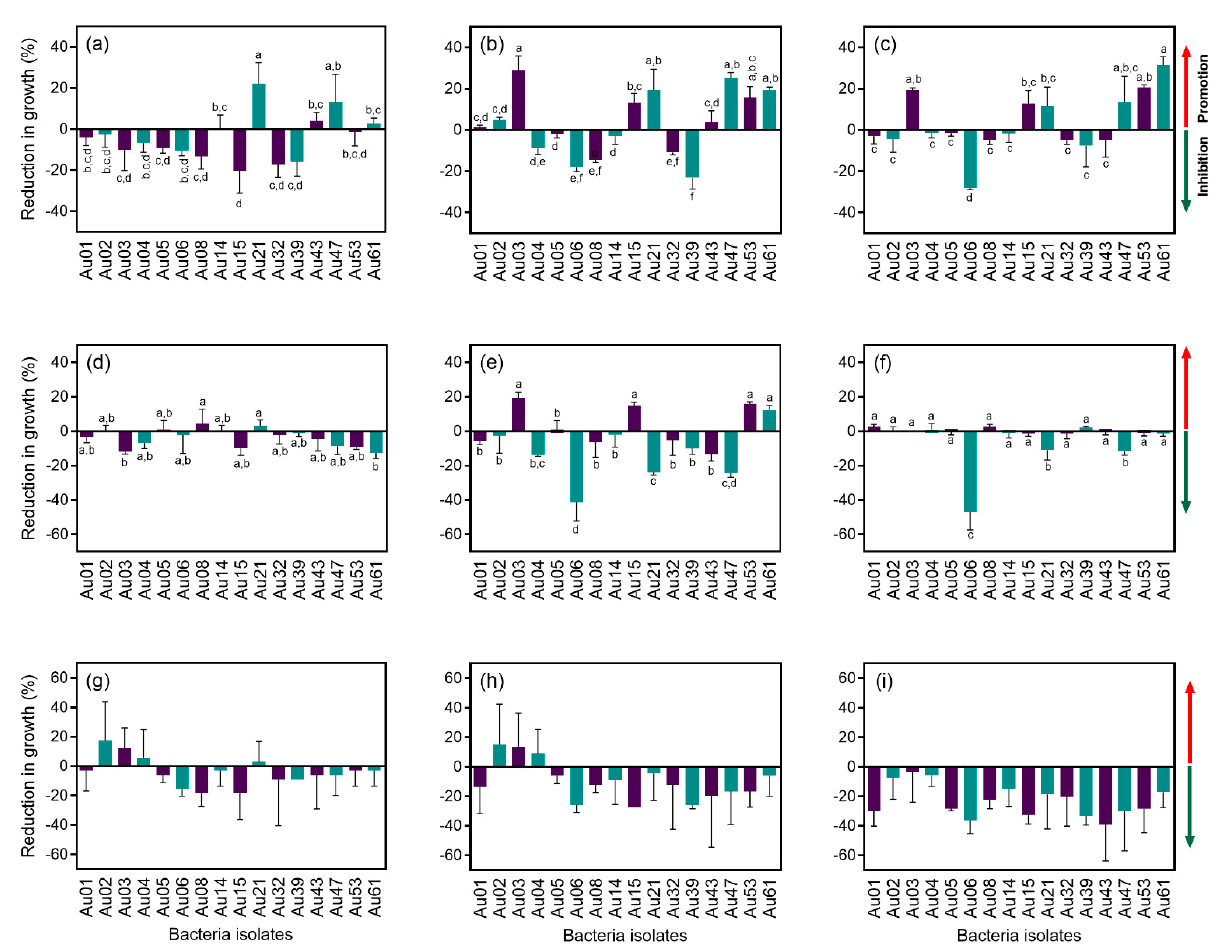
Figure 4. Antagonism assay between some of the endophytic bacteria isolated from Arbutus unedo and the plant pathogens Glomerella cingulata , Mycosphaerella aurantia and Phytophthora cinnamomi . Reduction in growth (%) was calculated after 1, 2 and 3 weeks for G. cingulata and P. cinnamomi , and after 3, 6 and 9 weeks for M. aurantia . ( a ) G. cingulata after 1 week; ( b ) G. cingulata after 2 weeks; ( c ) G. cingulata after 3 weeks; ( d ) M. aurantia after 3 weeks; ( e ) M. aurantia after 6 weeks; ( f ) M. aurantia after 9 weeks; ( g ) P. cinnamomi after 1 week; ( h ) P. cinnamomi after 2 weeks; ( i ) Phytophthora cinnamomi after 3 weeks. Bacteria isolates: Au01— Pseudomonas avellanae ; Au02— Bacillus toyonensis ; Au03— Paenibacillus humicus ; Au04— Bacillus megaterium ; Au05— Bacillus toyonensis ; Au06— Bacillus cereus ; Au08— Bacillus toyonensis ; Au14— Bacillus safensis ; Au15— Paenibacillus pabuli ; Au21— Bacillus simplex ; Au32— Paenibacillus marchantiophytorum ; Au39— Pseudomonas poae ; Au43— Sphingomonas panni ; Au47— Paenibacillus etheri ; Au53— Paenibacillus taichungensis ; and Au61— Bacillus taxi . Means ± standard deviations, n = 3; different letters indicate significant differences between treatments ( p ≤